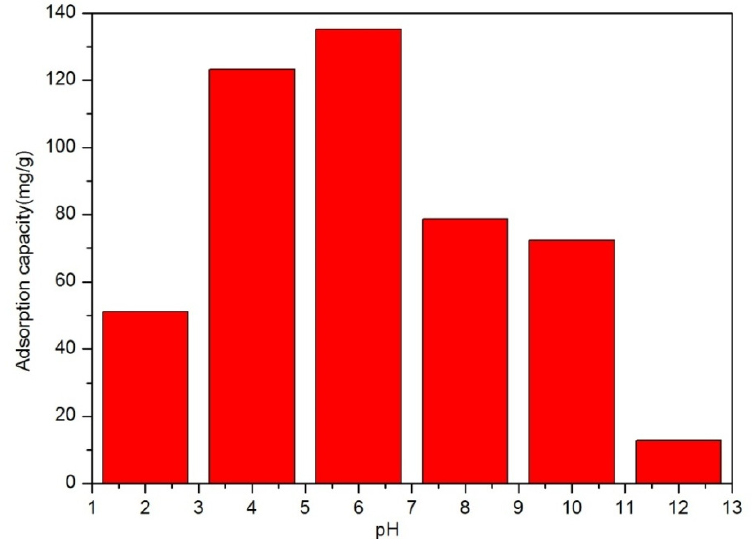
Figure 7. Adsorption Capacity of different pH on Fe-MOFs (50 mg, 50 ppm, 20 °C).